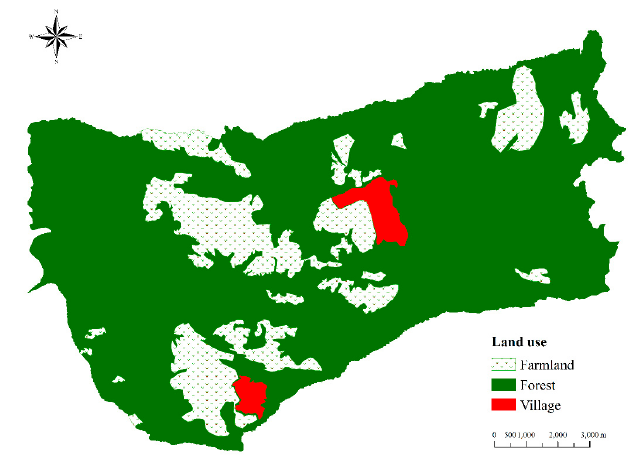
Figure 2. The land use types in Liangshan Town catchment.